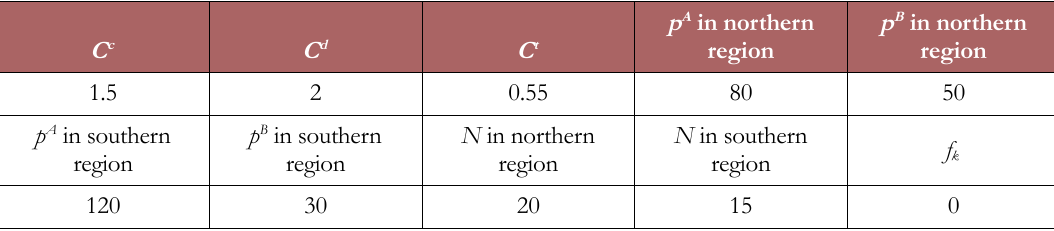
Table 1. The fixed parameter